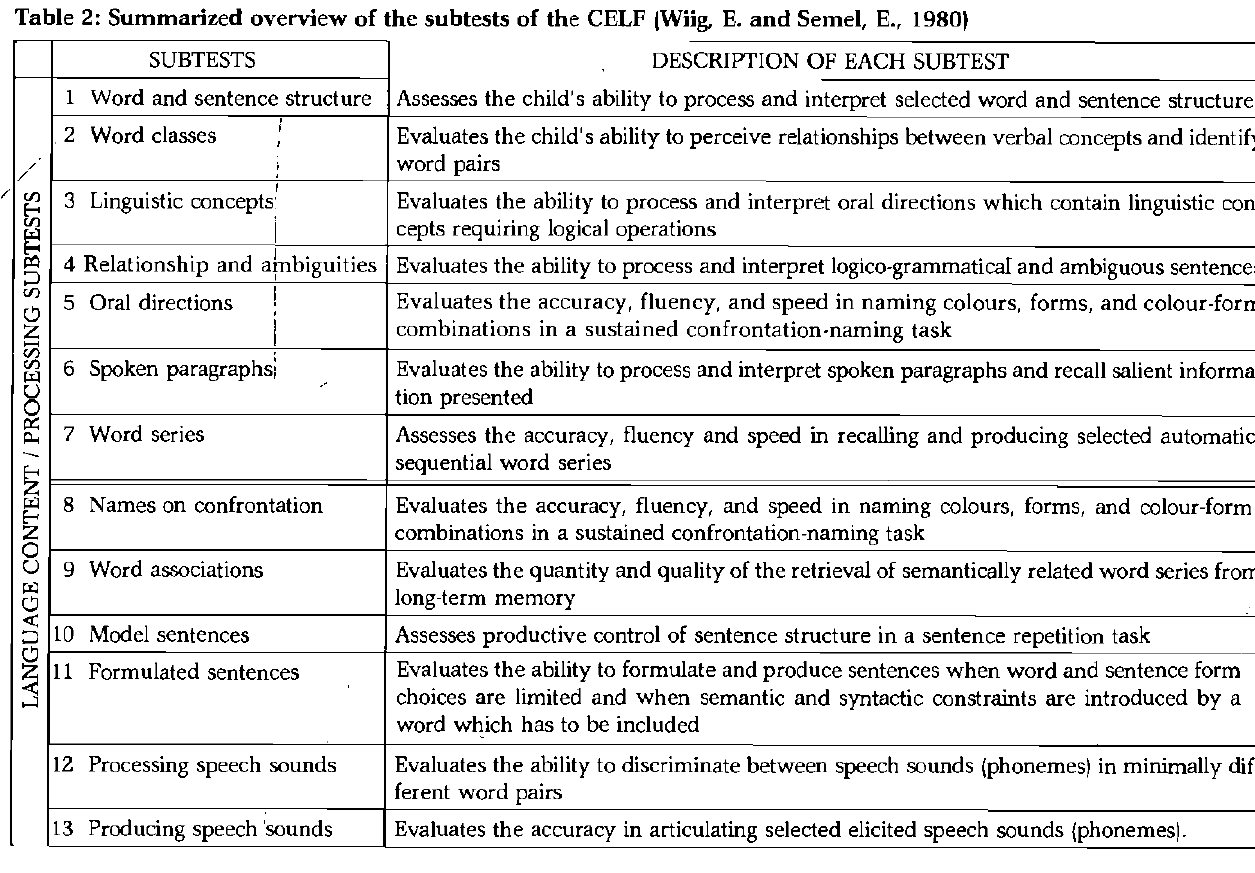
13 Producing speech sounds Die Suid-Afrikaanse Tydskrif vir Kommunikasieafwykings, Vol. 35,